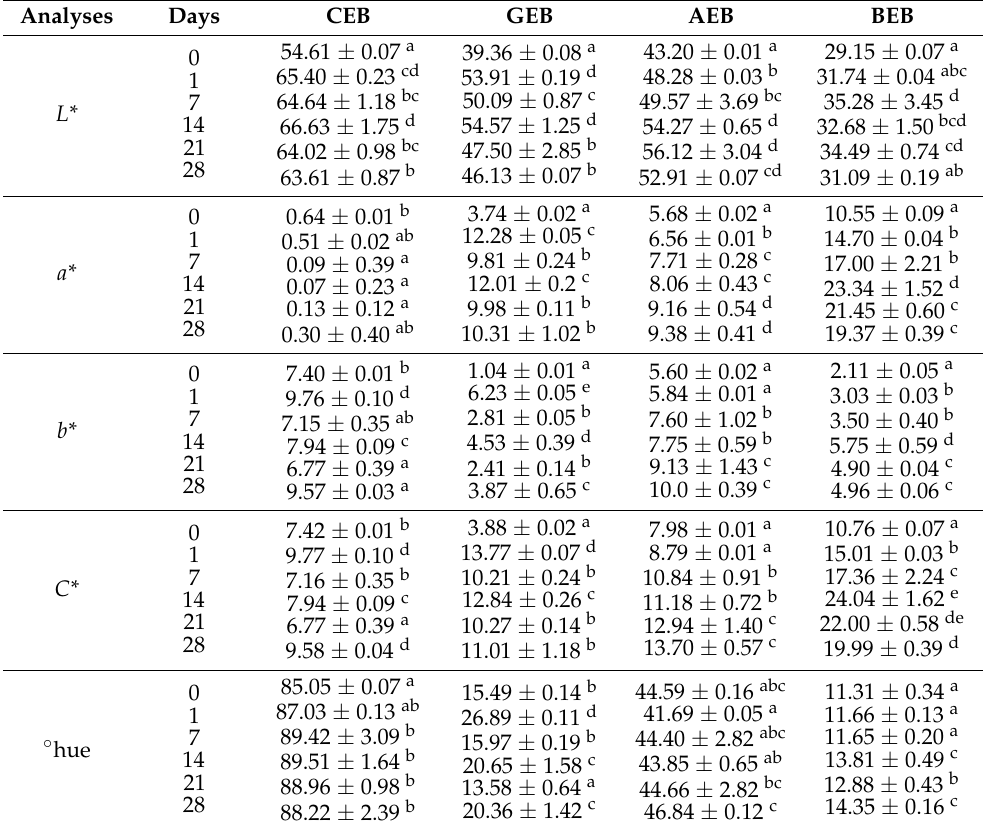
Table 4. Effect of storage on color characteristics of the